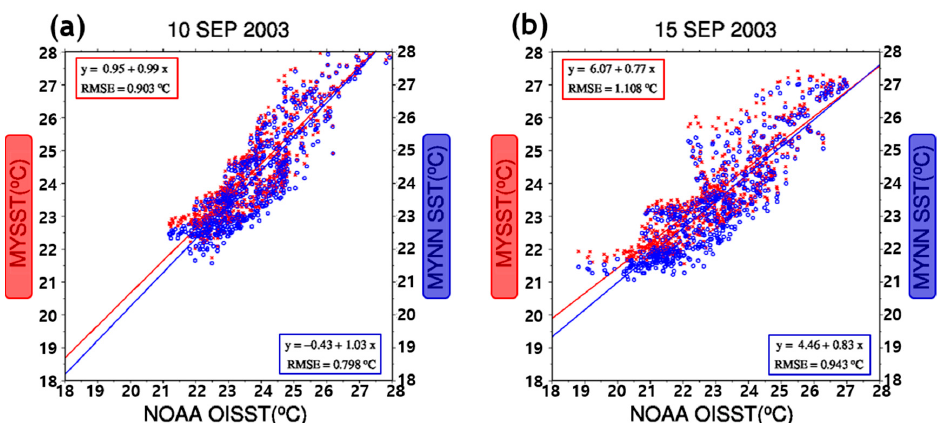
Figure 4. Scatter diagram between the sea surface temperatures (SSTs) south of 40 °N obtained from satellite data and simulated using the Mellor–Yamada (MY) (red dots and line) and the Mellor–Yamada–Nakanishi–Niino (MYNN) (blue dots and line) models ( a ) before and ( b ) after Typhoon Maemi. (RMSE, root mean square